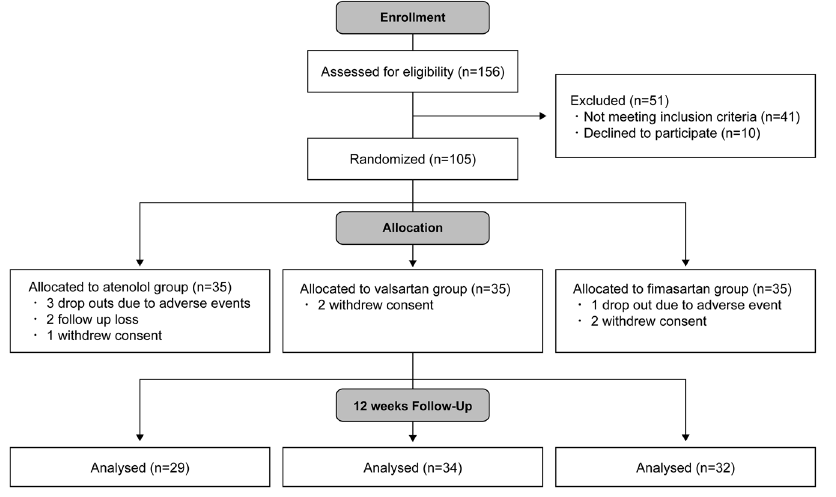
Figure 1. Consort flow chart of this